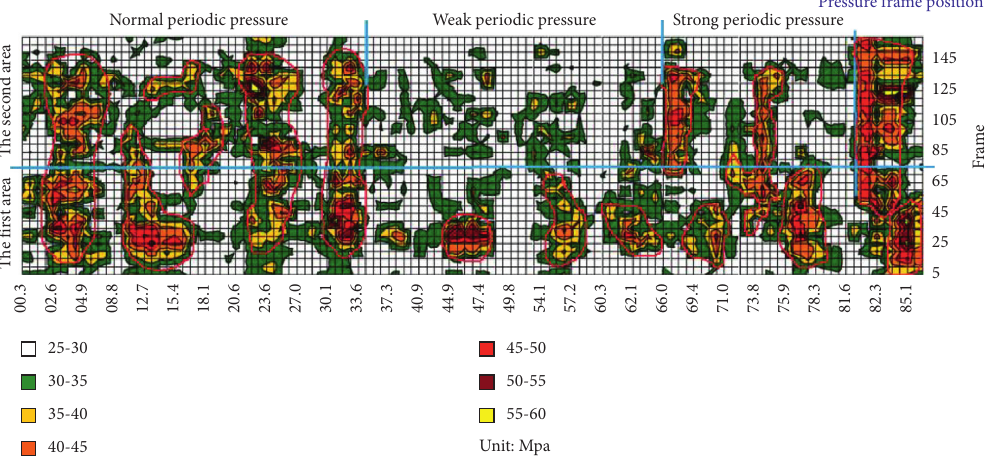
Figure 6: Surface map of ground pressure during the support pressing of the 22306 fully working face.